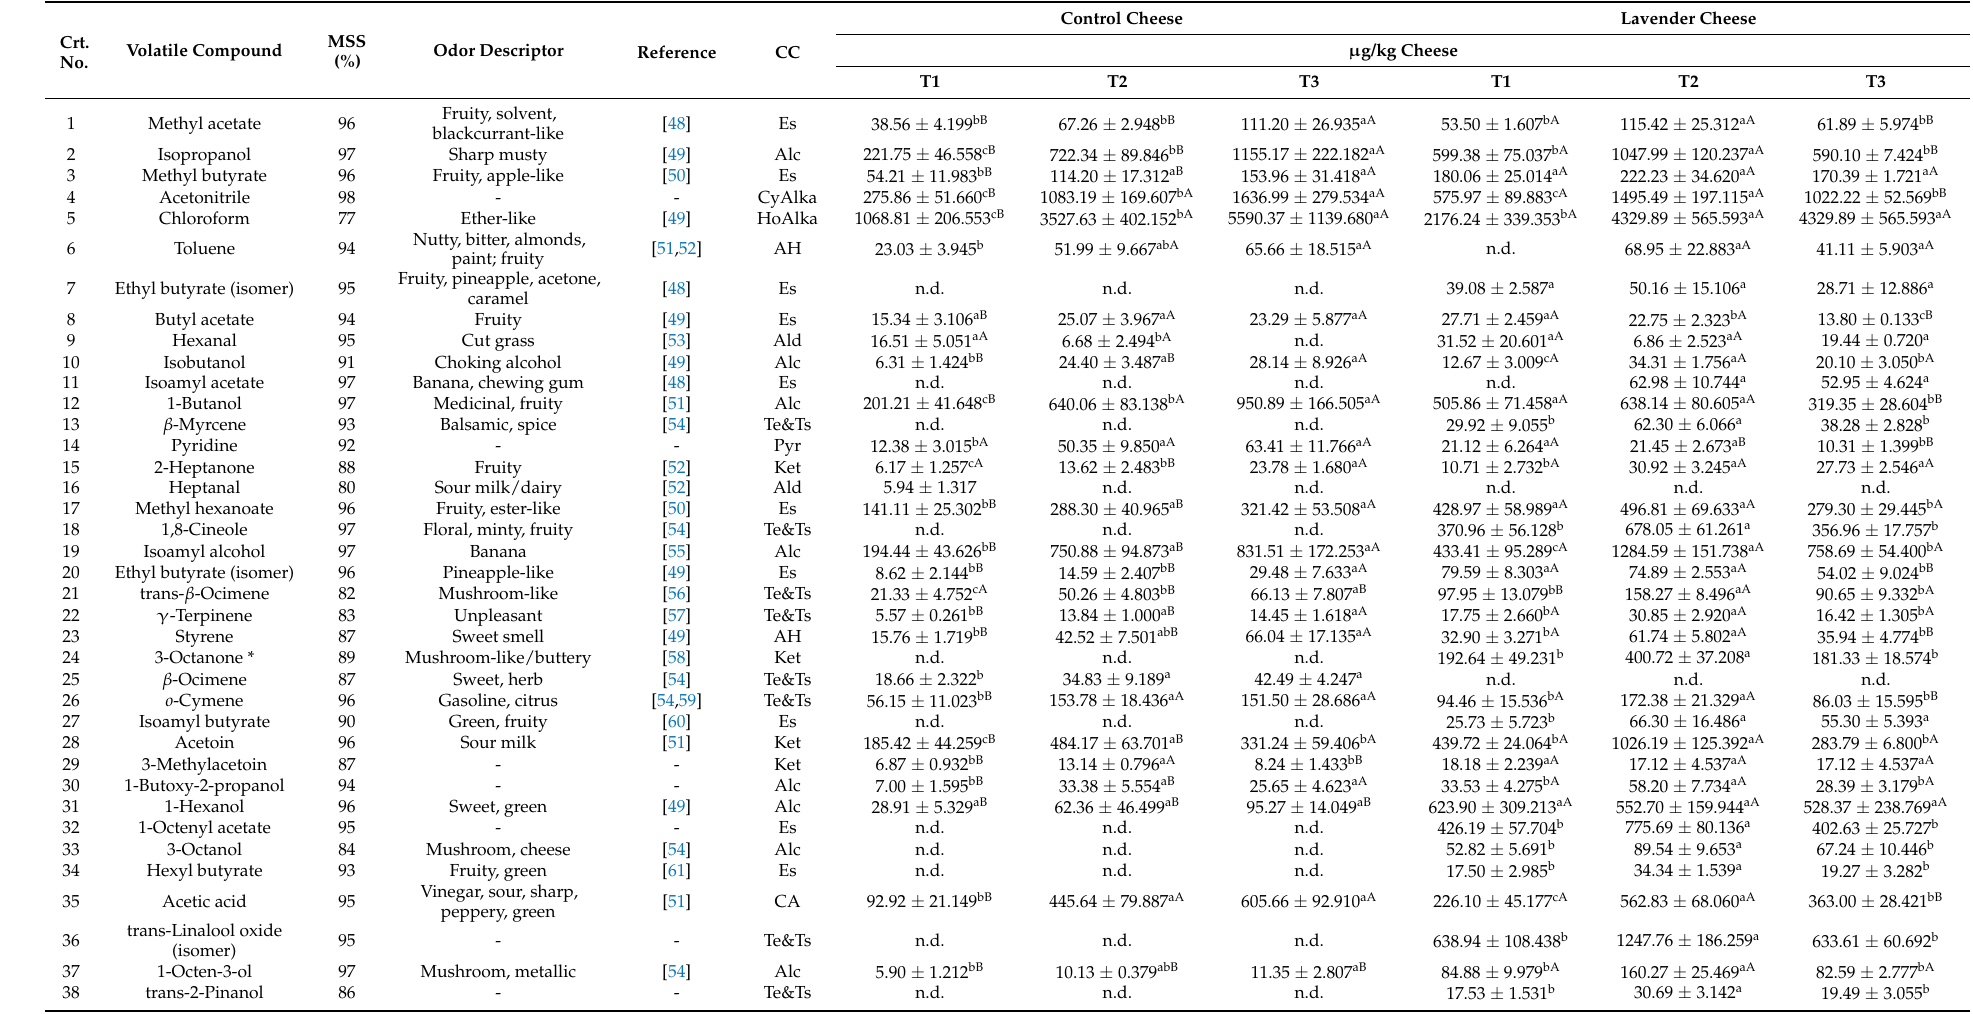
Table 4. Volatile compound concentrations in control and lavender Gouda-type cheese at different ripening times (T1, T2, and T3). Crt.